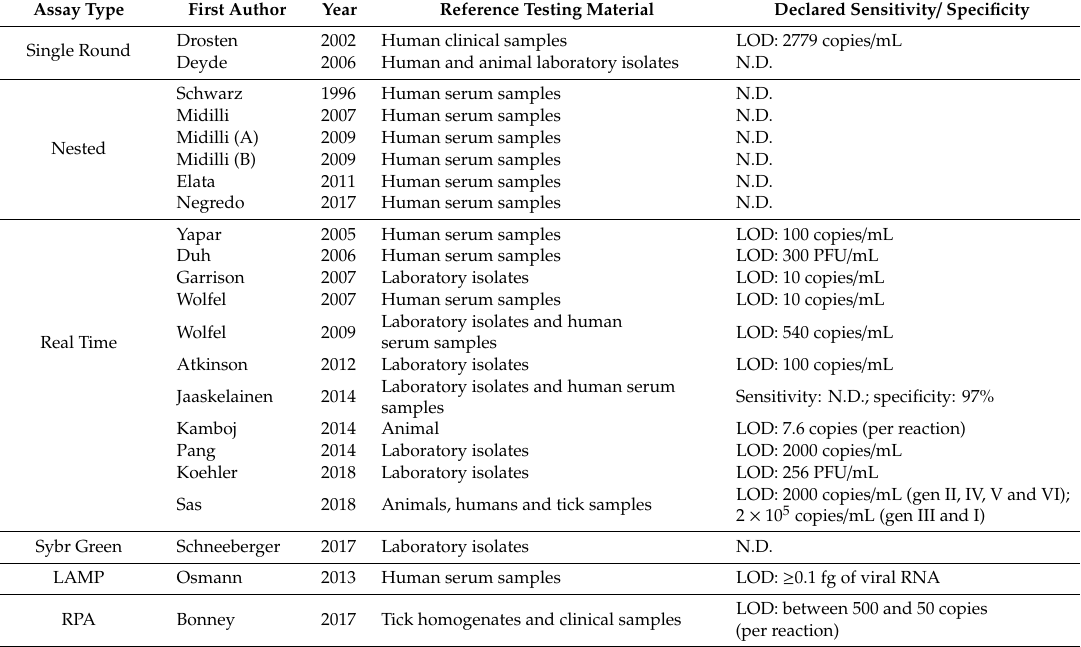
Table 1. Molecular assays for CCHFV detection published until 2018. For each assay, the type of molecular assay, the publication’s first author, the publication year, reference testing materials, and sensitivity / specificity of the tests are